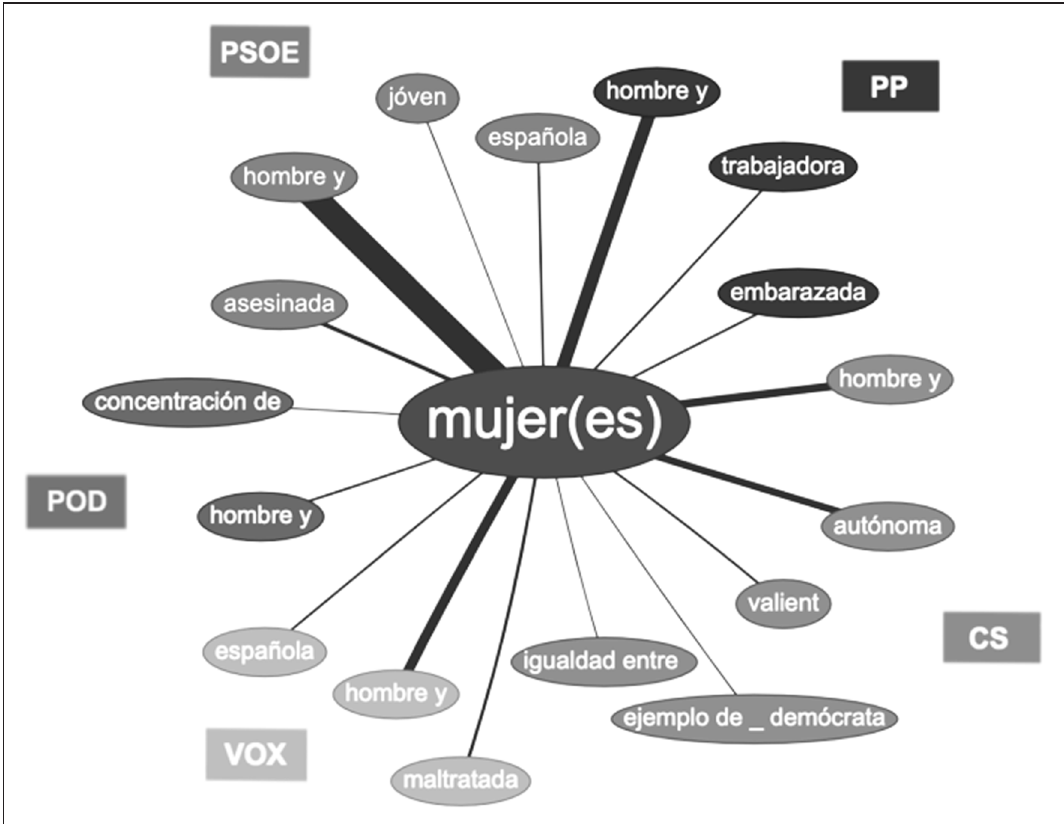
Figure 3: Qualified nouns containing mujer and